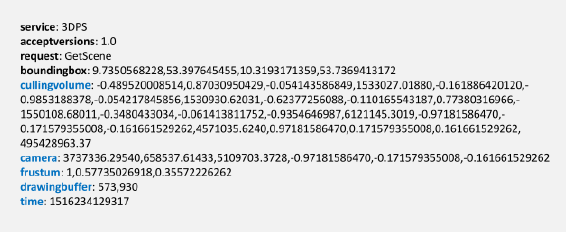
Figure 14. I3S scene of Berlin with camera position at 400 meters rendered in ArcGIS JavaScript API (left) and extended 3D Portrayal Service/Cesium (right).